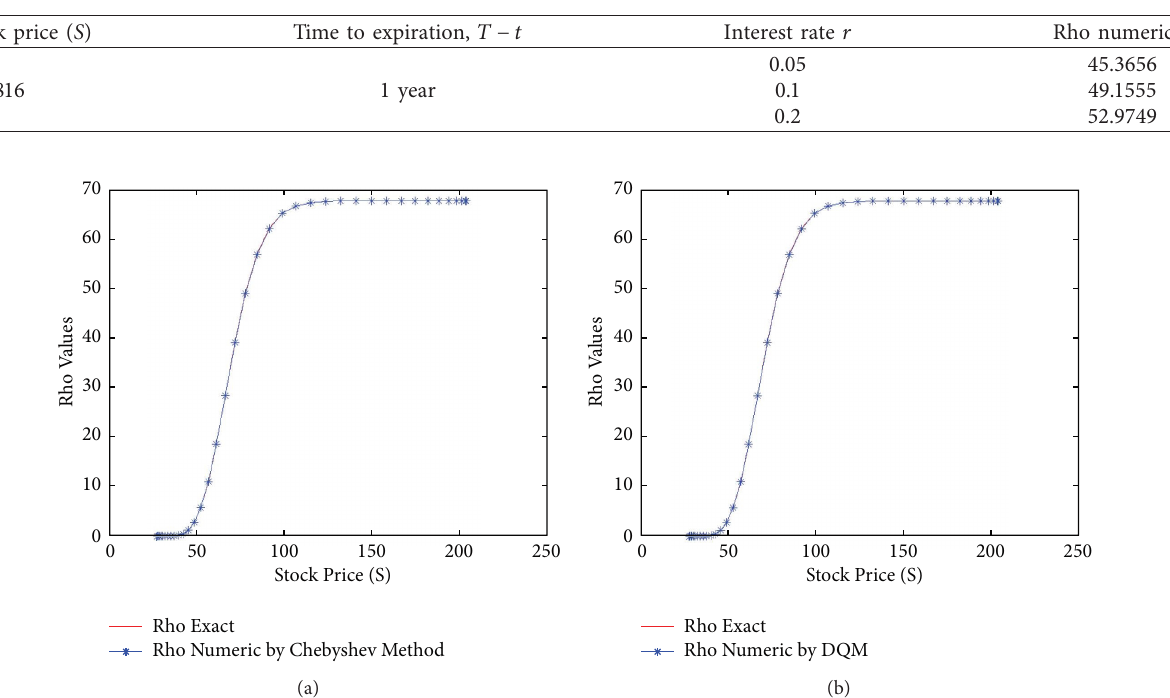
Figure 16: We plot exact and numerical values of rho at time t � 0. (a) is for the Chebyshev method, and (b) is for the DQM.